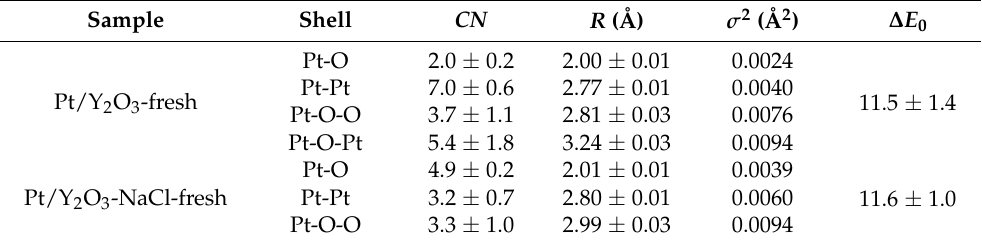
Figure 5. Pt L3-edge XANES profiles ( a ) and EXAFS fitting results ( b ) in R space for fresh Pt/Y 2 O 3 - NaCl and Pt/Y 2 O 3 catalysts. Table 2. EXAFS fitting results for fresh Pt/Y 2 O 3 -NaCl and Pt/Y 2 O 3 catalysts